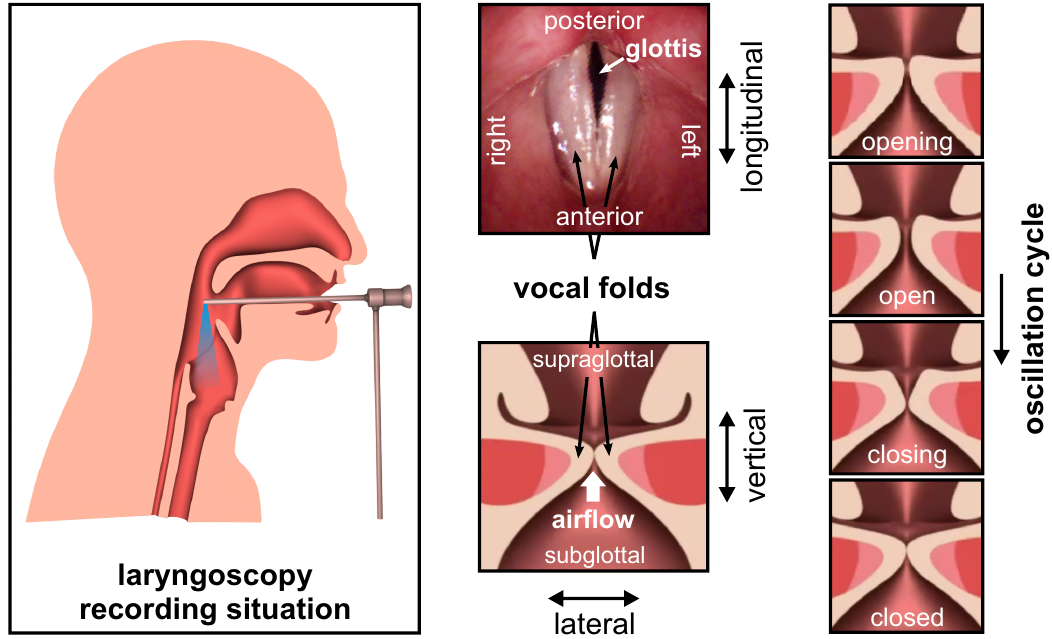
Figure 1. Schematic overview of the three-dimensional vocal fold vibration during phonation: The vertical displacement amplitudes are in the same magnitude as the mainly and commonly analyzed lateral displacement amplitudes